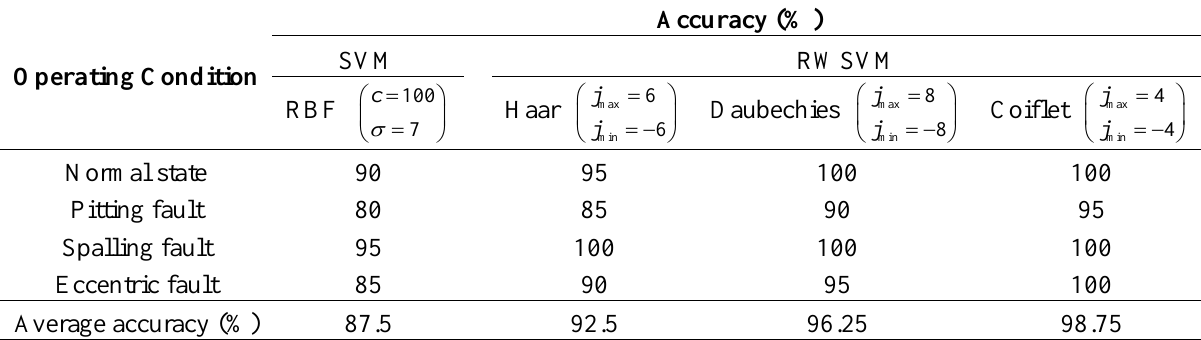
Table 2. The classified result of gear transmission system test data.